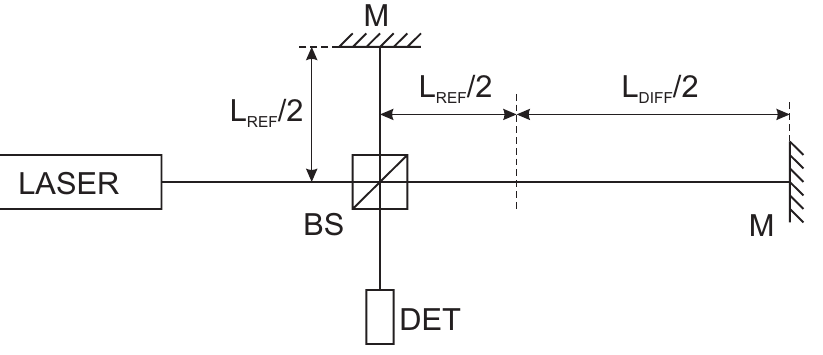
Figure 1. Principal schematic of a Michelson interferometer; BS—beamsplitter, M—mirrors, DET—photodetector, L —optical length of reference arm, L REF between optical lenghts of reference and measuring arm of the